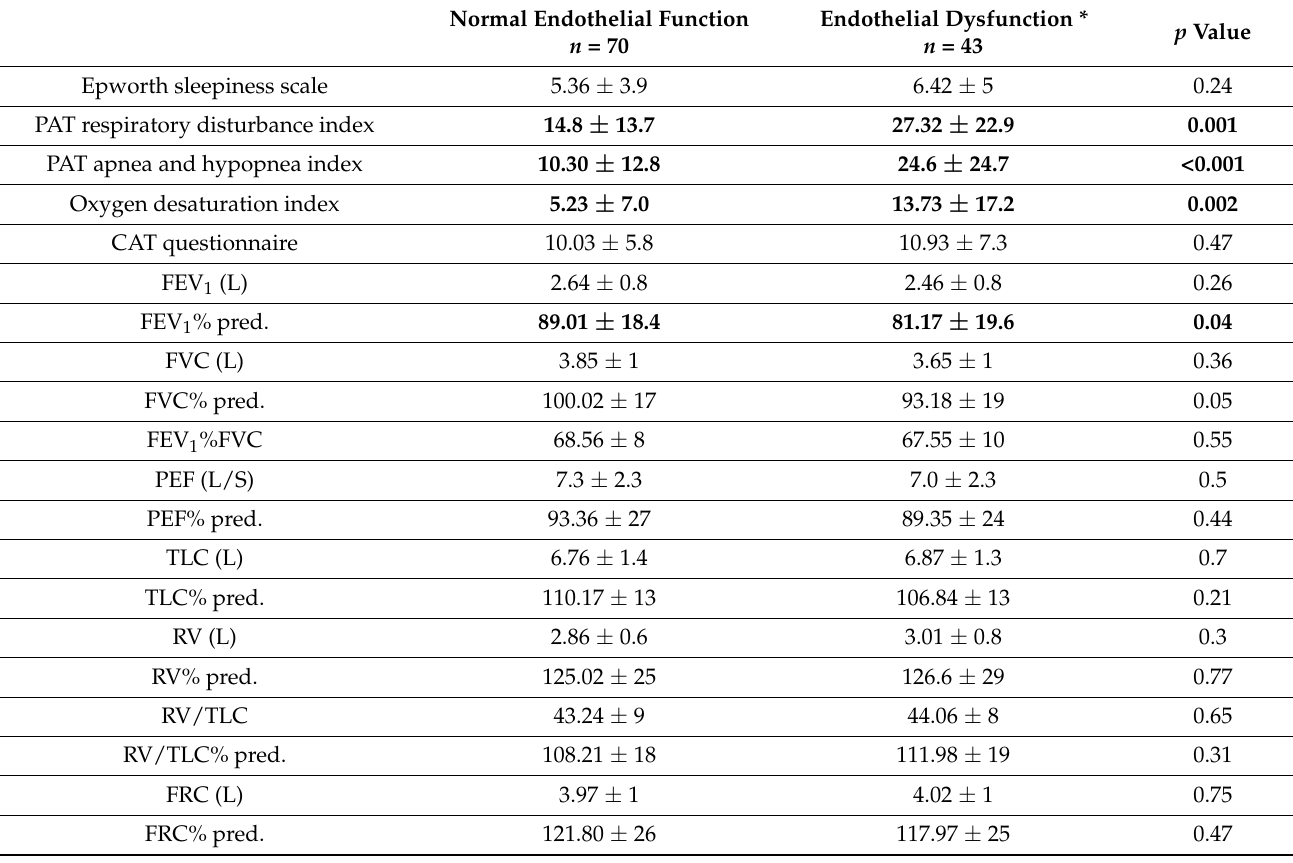
Table 3. Polygraphy and pulmonary function tests data.